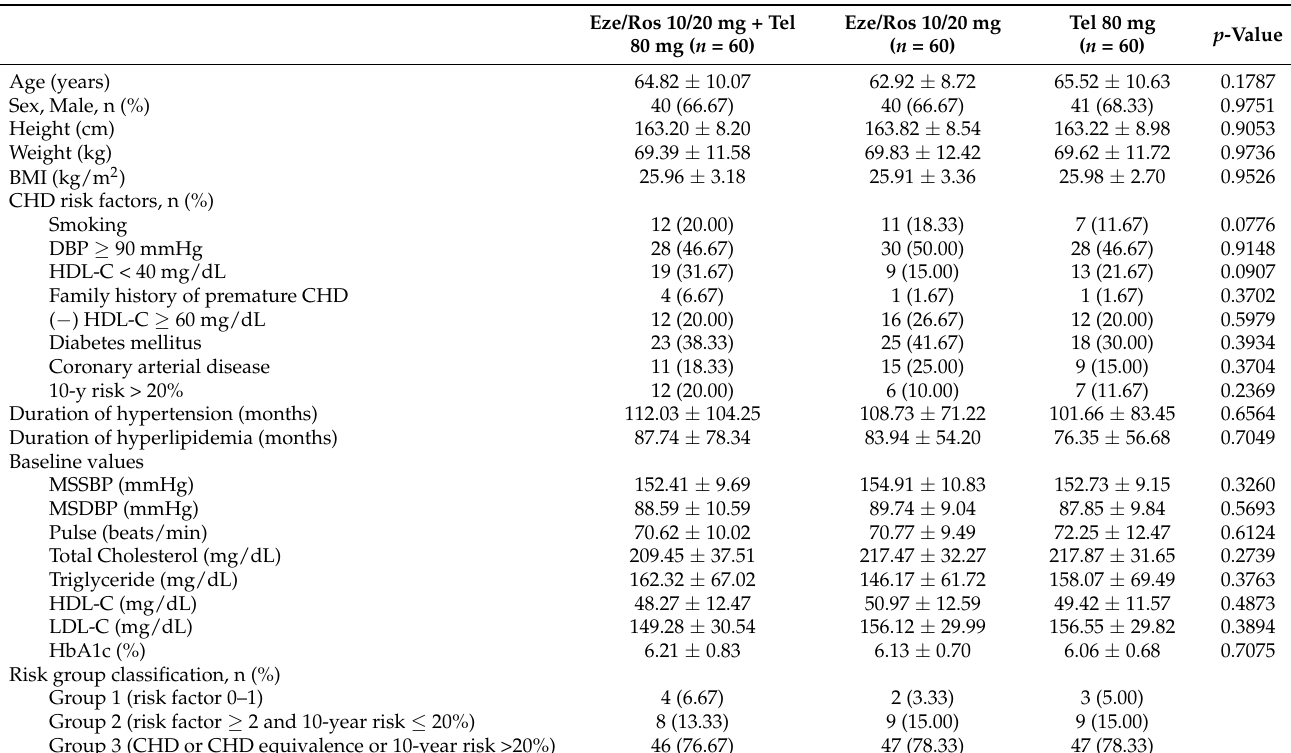
Figure 1. Study flow. Table 1. Baseline characteristics of the patients.